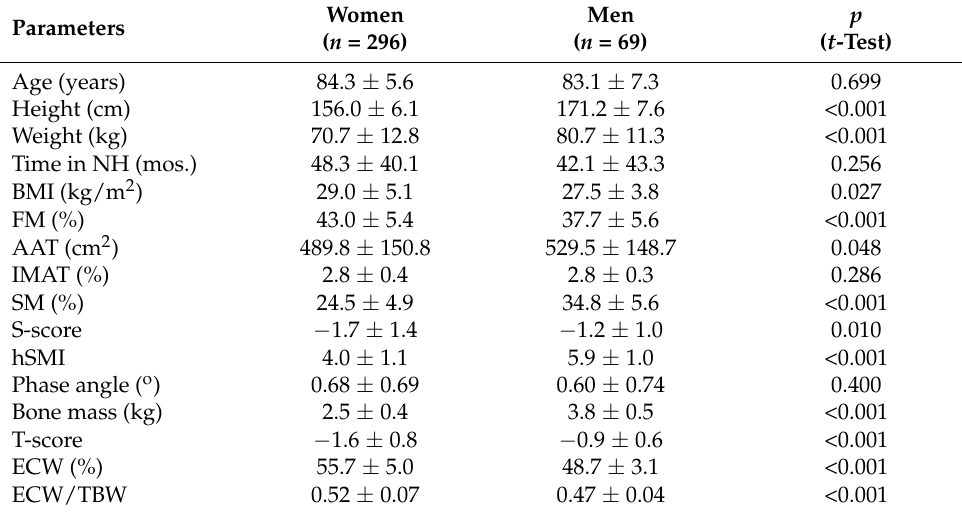
Table 1. Body composition parameters in women and men (mean ± SD). Parameters